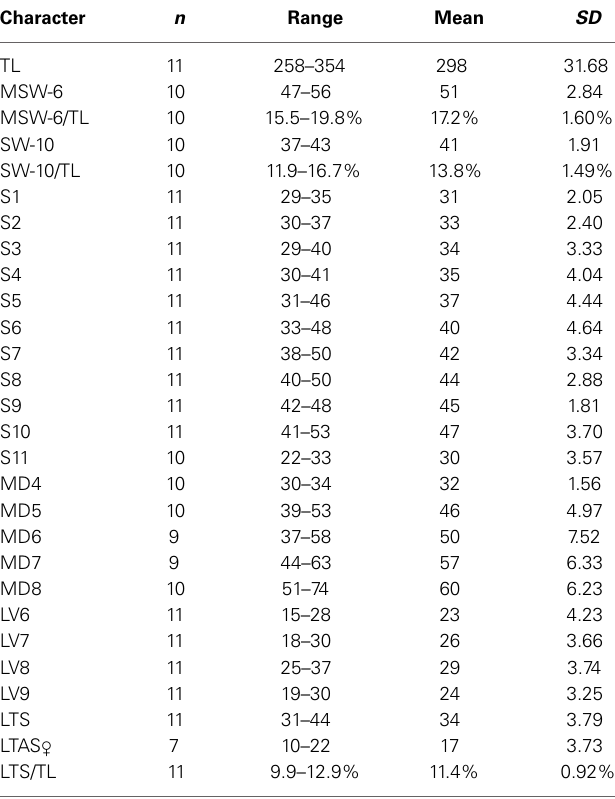
Table 2 | Measurements from light microscopy of adult Echinoderes augustae sp. nov. (in µ m), including number of measured specimens ( n ), and standard deviation ( SD ).